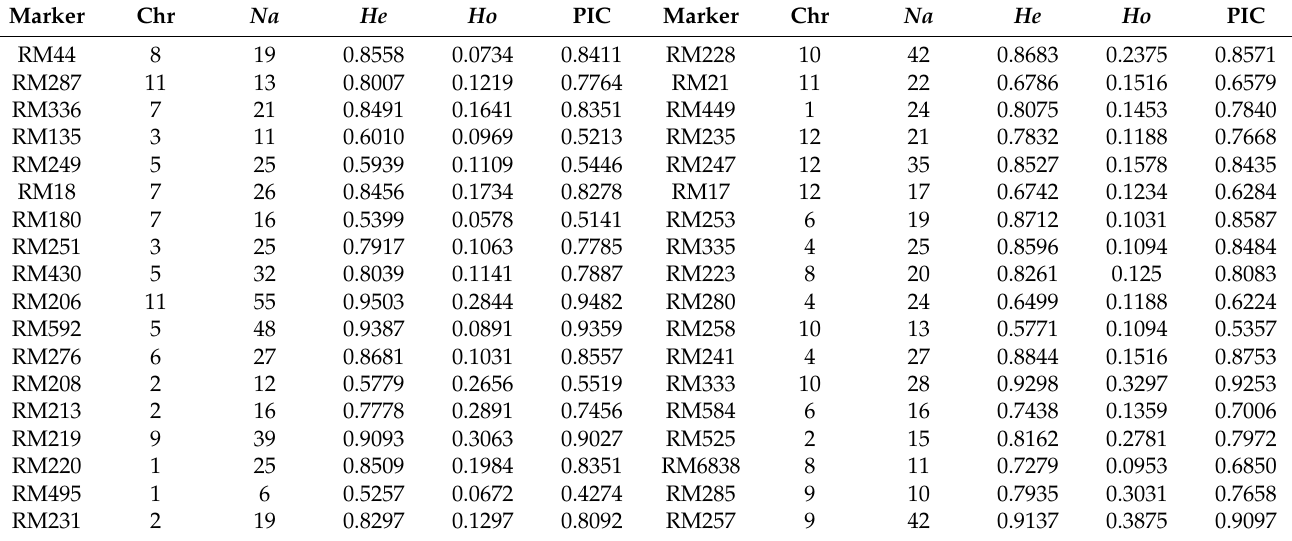
Table 2. Summary of genetic diversity among 640 accessions at 36 SSR